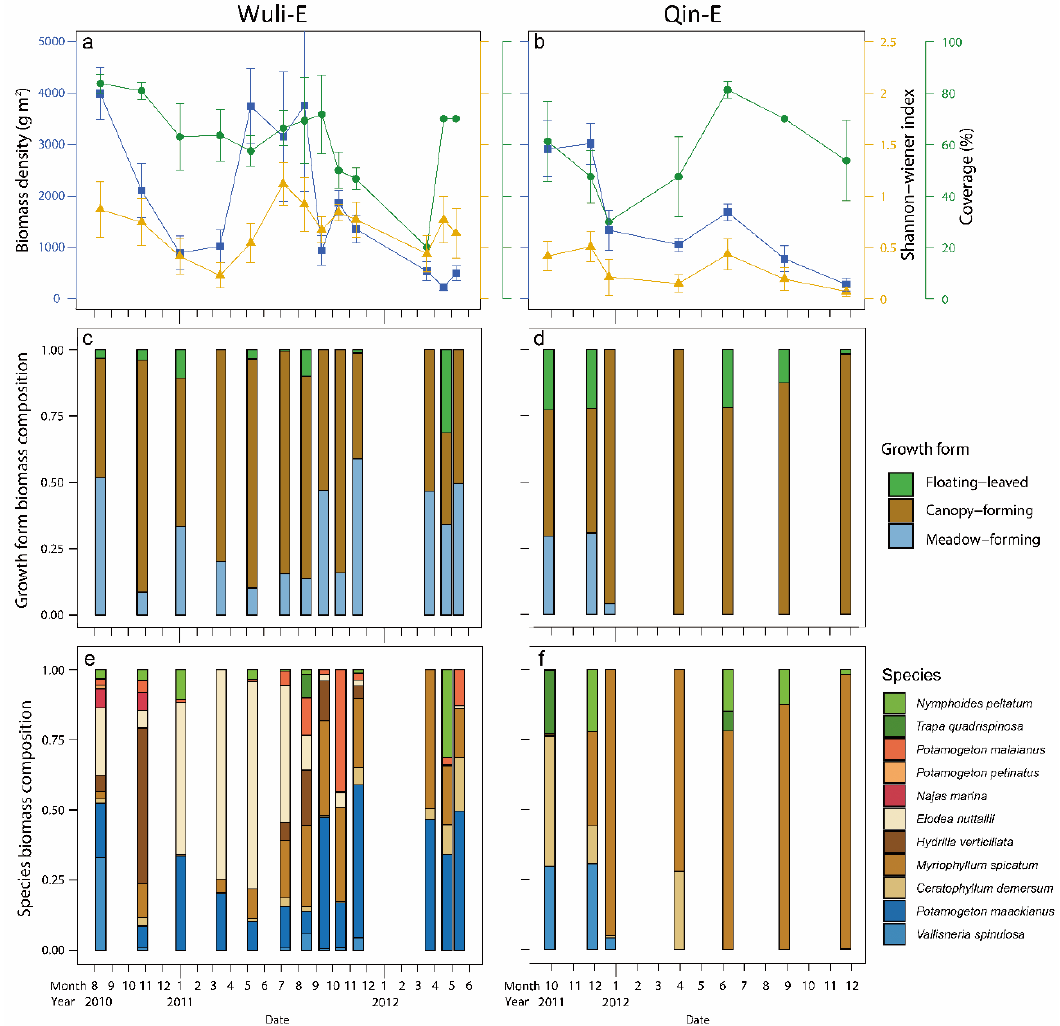
Figure 2. Dynamics of macrophyte biomass density (blue solid squares corresponding to blue vertical axis in ( a ) and ( b )), Shannon–Wiener diversity index (orange solid triangles corresponding to orange vertical axis in ( a ) and ( b )), coverage (green solid cycles corresponding to green vertical axis in ( a ) and ( b )) and growth form biomass composition (( c ) and ( d )) and species composition (( e ) and ( f )) of the restored areas in Lake Wuli (Wuli-E, left panel) and Lake Qinhu (Qin-E, right panel) after macrophyte transplantation (mean values represented the average data for 3 sampling sites in restored lake area in each sampling time). Error bars represent the SE (standard error) of different sampling sites in each sampling time.